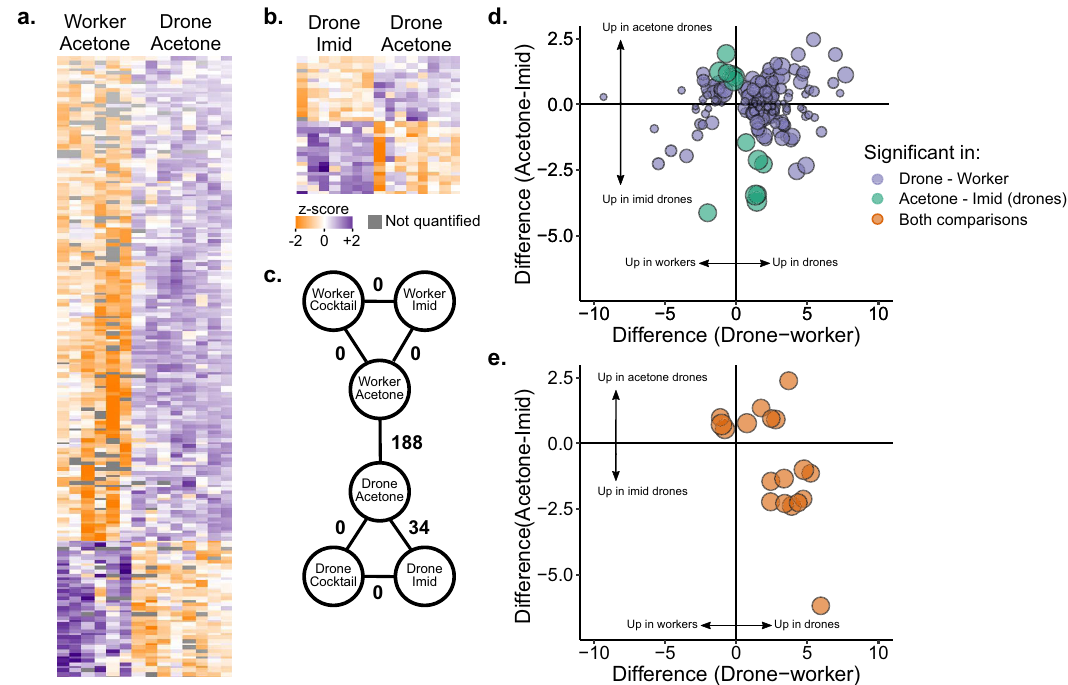
Fig. 3 Quantitative proteomics on surviving drone and worker hemolymph after topical exposure to pesticides. Workers and drones exposed to the pesticide cocktail (2 µ l of 10 x solution in acetone, where x = the median concentration in wax), imidacloprid (2 µ l of 1 ppm solution in acetone), and a negative control (2 µ l of acetone). a Label-free quantitative proteomics results comparing negative control drones and workers. Each row is a protein and each column is a sample. Only signi fi cant differences (5% FDR, Benjamini Hochberg correction) are depicted. b Proteins differentially expressed between imidacloprid-exposed drones and controls. c Summary of statistical analyses comparing different groups. Numbers indicate the number of proteins differentially expressed at 5% FDR. d Summary of signi fi cance and direction of change in expression for proteins differentially expressed in drones vs. workers (purple), and imidacloprid vs. control drones (green). Circle size is proportional to − log(p value) for the drone imidacloprid vs. acetone comparison. e Proteins differentially expressed in both statistical comparisons. Circle size is proportional to − log( p value) for the drone imidacloprid vs. acetone comparison. Underlying data can be found in Supplementary Data 4, and summary statistics of these data are in Supplementary Data